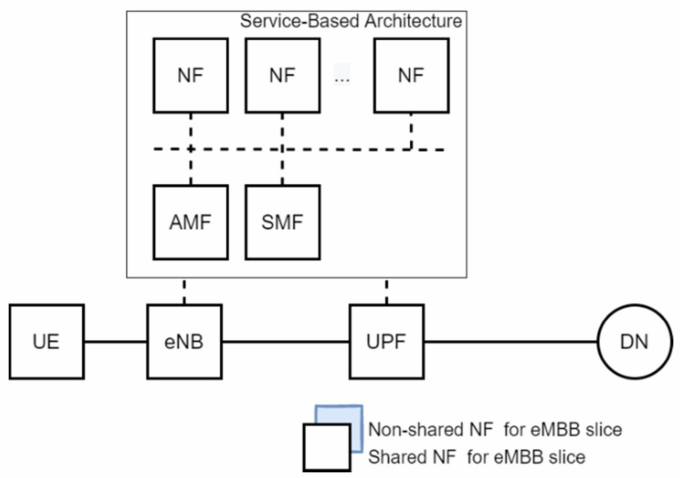
Figure 11. Network Slice with no security. NF: Network Function; AMF: Access and